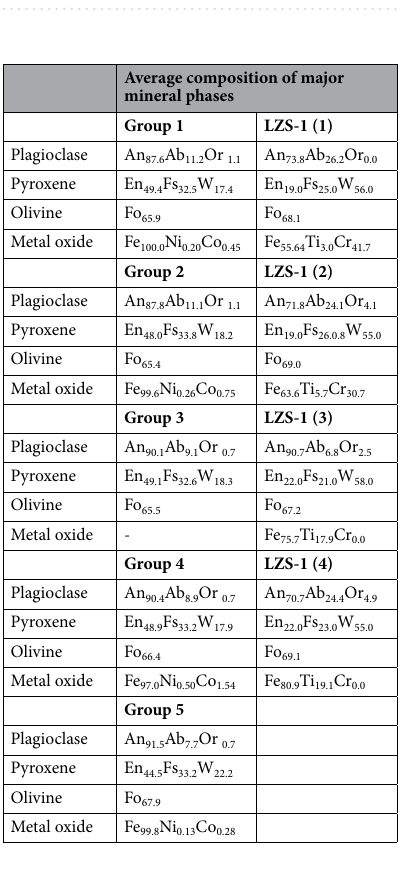
Figure 8. Chondrite-normalized REE distribution pattern of LZS-1 lunar soil simulant and compared with 5 groups of basaltic lunar samples with high Al 25 normalized to chondrite according to Evensen. et al. 26 .